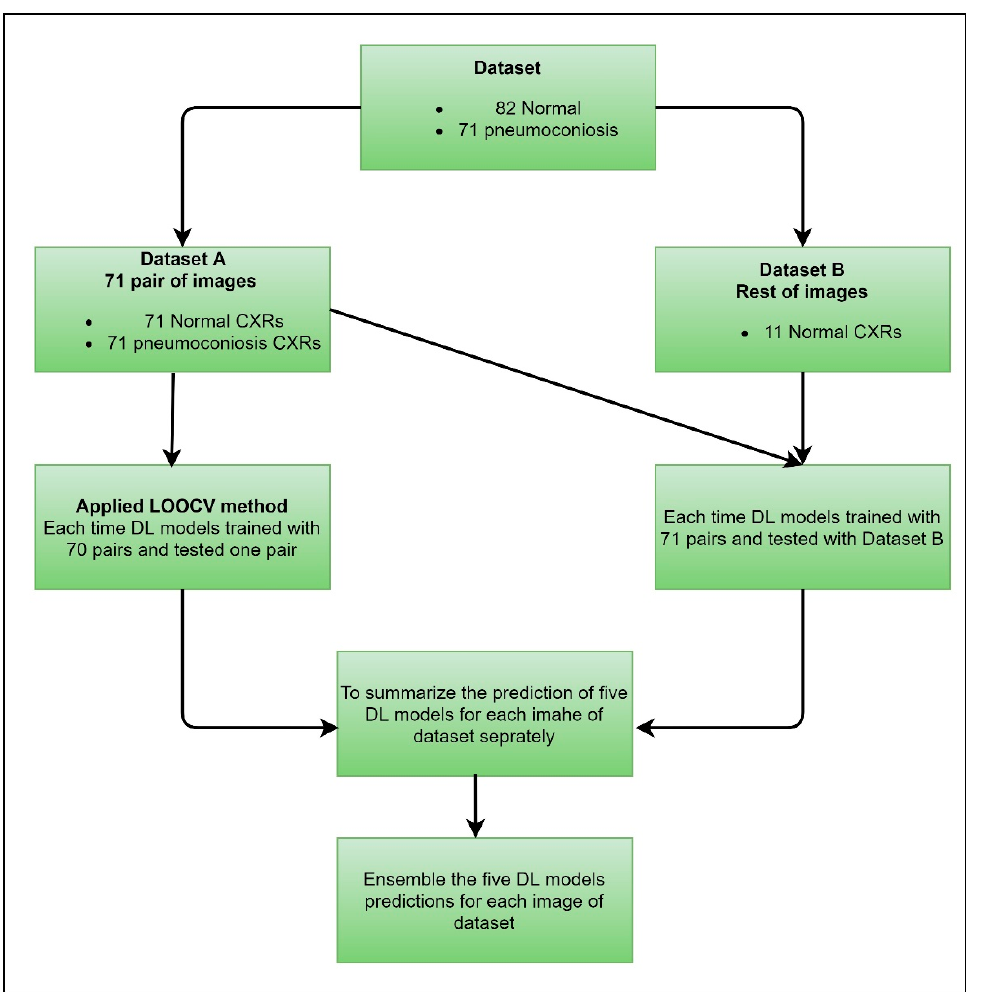
Figure 6. Applying the LOOCV method for the detection of pneumoconiosis using a deep learning algorithm.